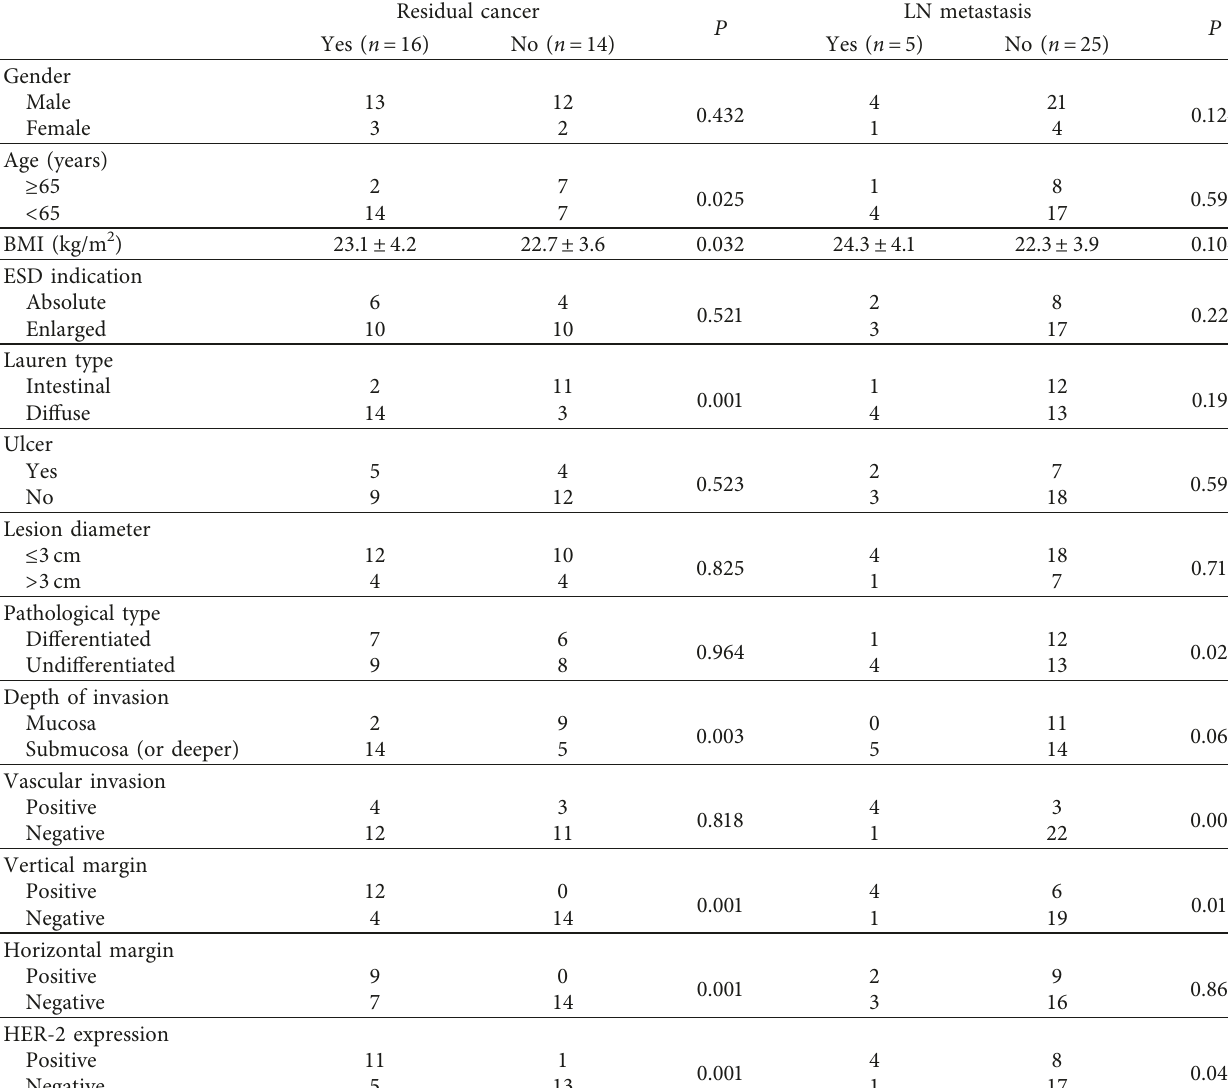
Table 1: Characteristics of patients with noncurative